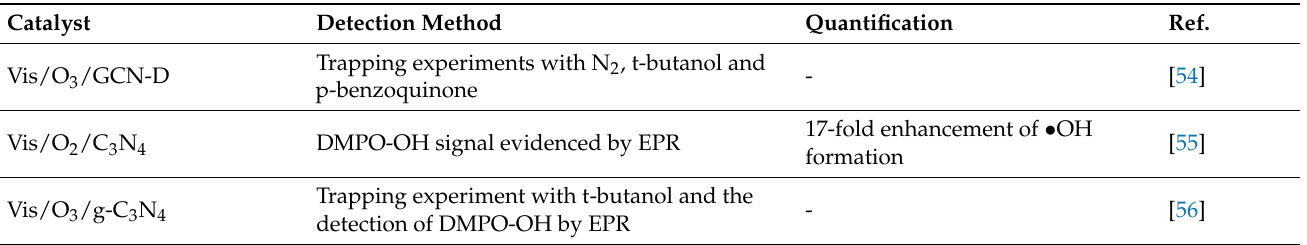
Table 1. Summary of the of detection of • OH radicals and their quantification by g-C 3 N 4 catalysts under visible-light irradiation with O 3